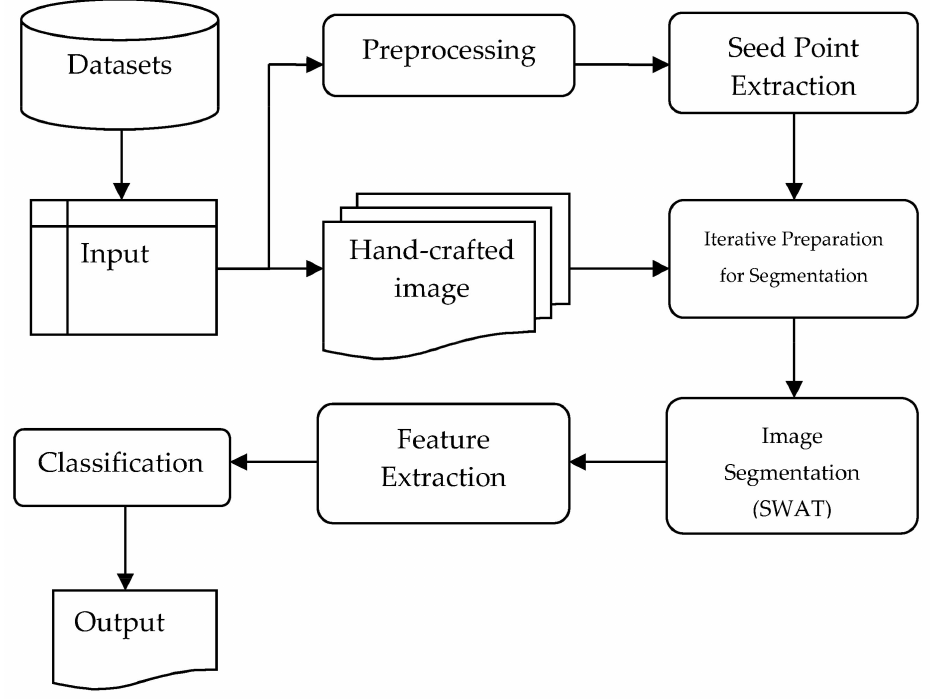
Figure 2. Block diagram depicting the proposed